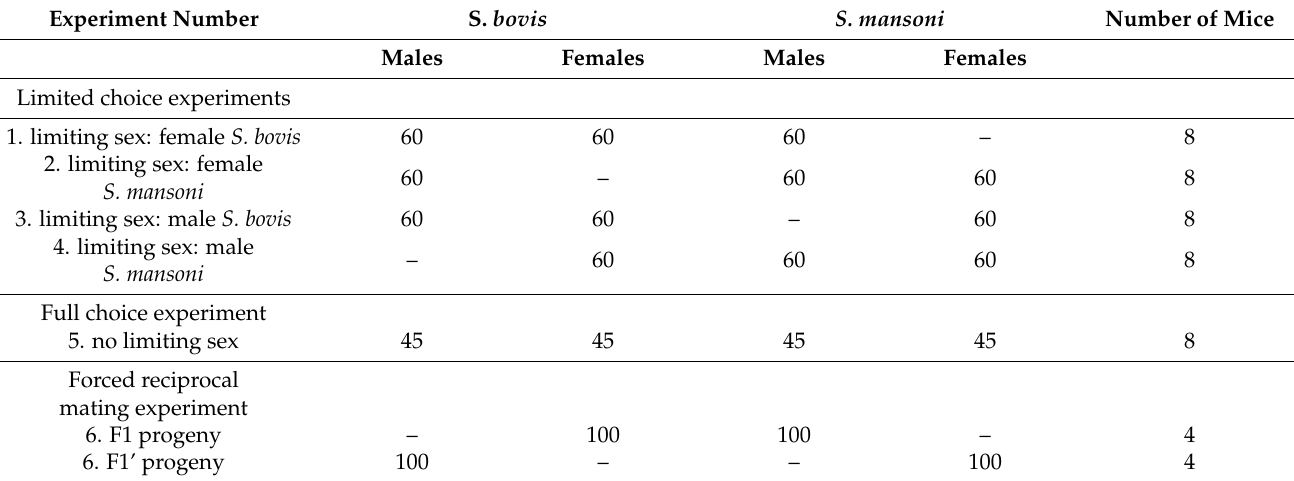
Table 1. Number of cercariae used for each experiment according to sex and species of parasite. Experiment